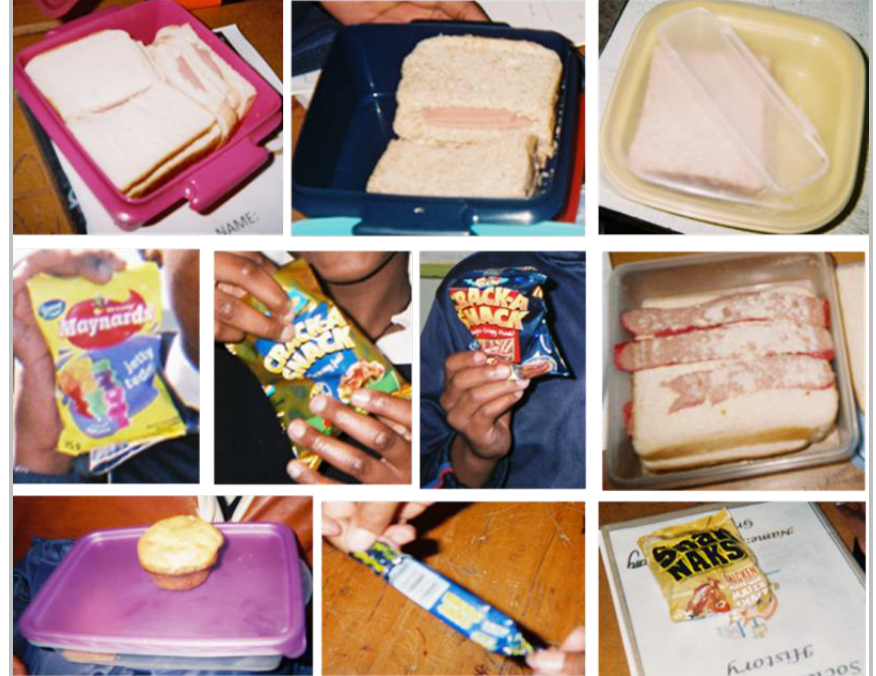
Figure 6. Photographs taken by grade 7 learners of their lunch boxes and snacks eaten at school.